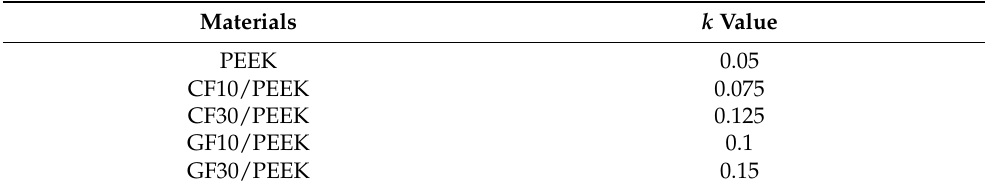
Table 6. k values for different